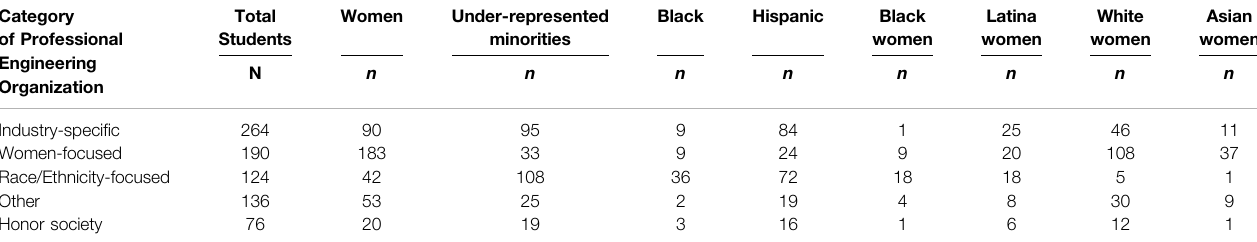
TABLE 4 | Participation in Professional Engineering Organizations by Category, Gender, and Race/Ethnicity Intersection (Survey